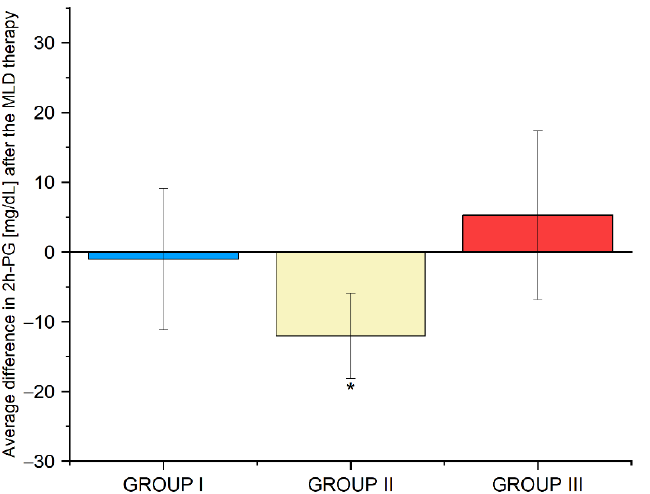
Figure 2. Average differences in 2h-PG levels in group I, II and III before and after the use of MLD